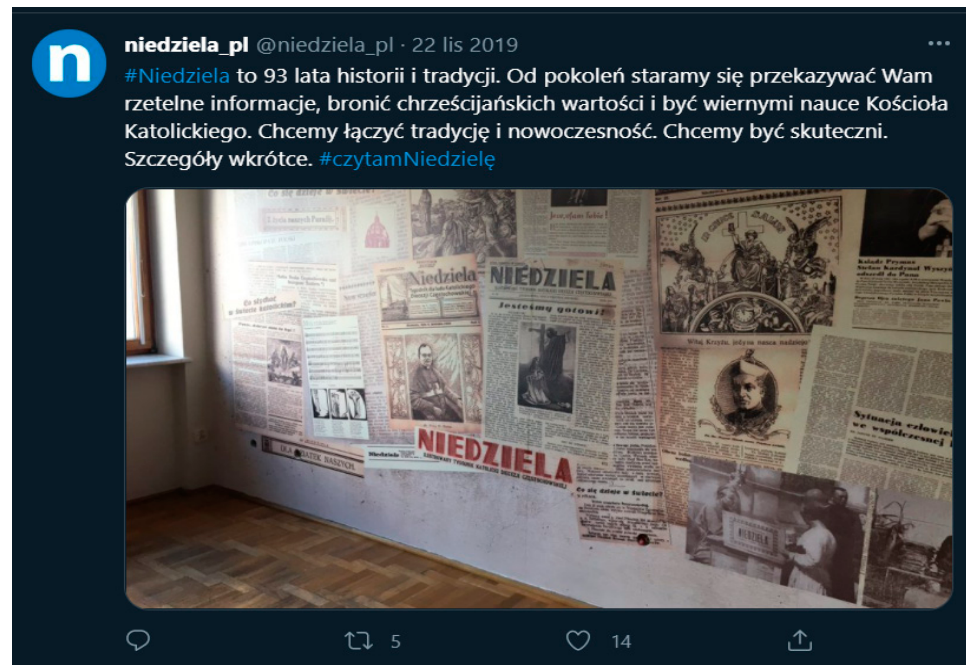
Figure 2. A self-promotional tweet by Tygodnik Katolicki Niedziela , 22.11.2019. Source: Twit- ter/screenshot.